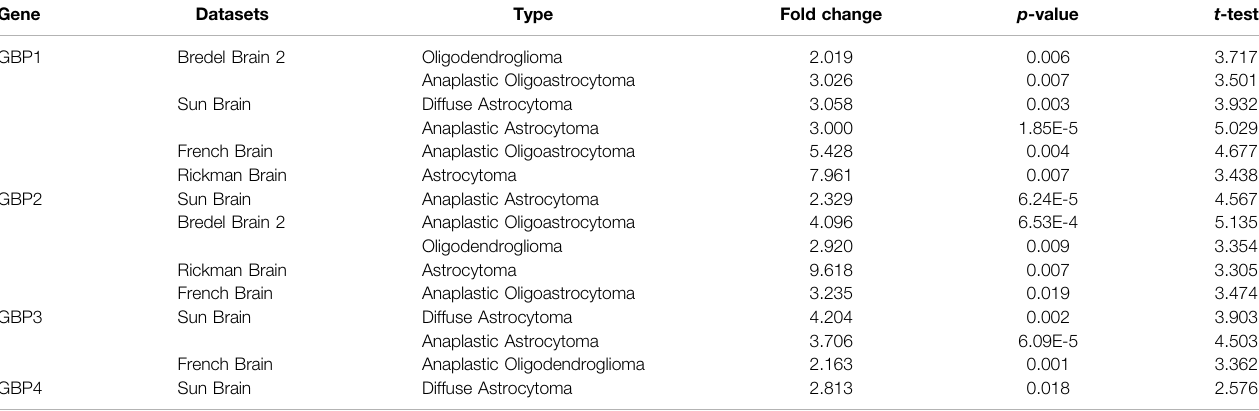
TABLE 1 | Signi fi cant changes of GBPs expression in different types of LGG tissues vs normal brain tissues (ONCOMINE). Gene Datasets Type Fold change p -value GBP1 Bredel Brain 2